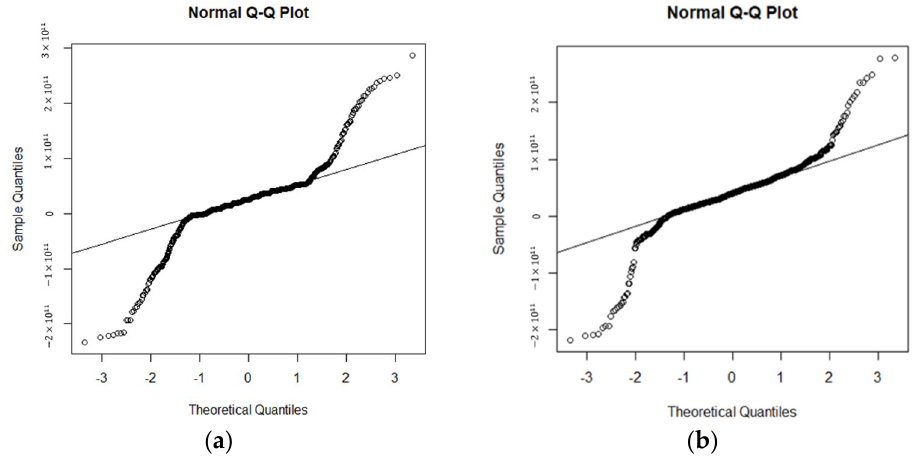
Figure 1. QQ plot results from the MEBoot data of the ( a ) downtime and ( b ) timeout.